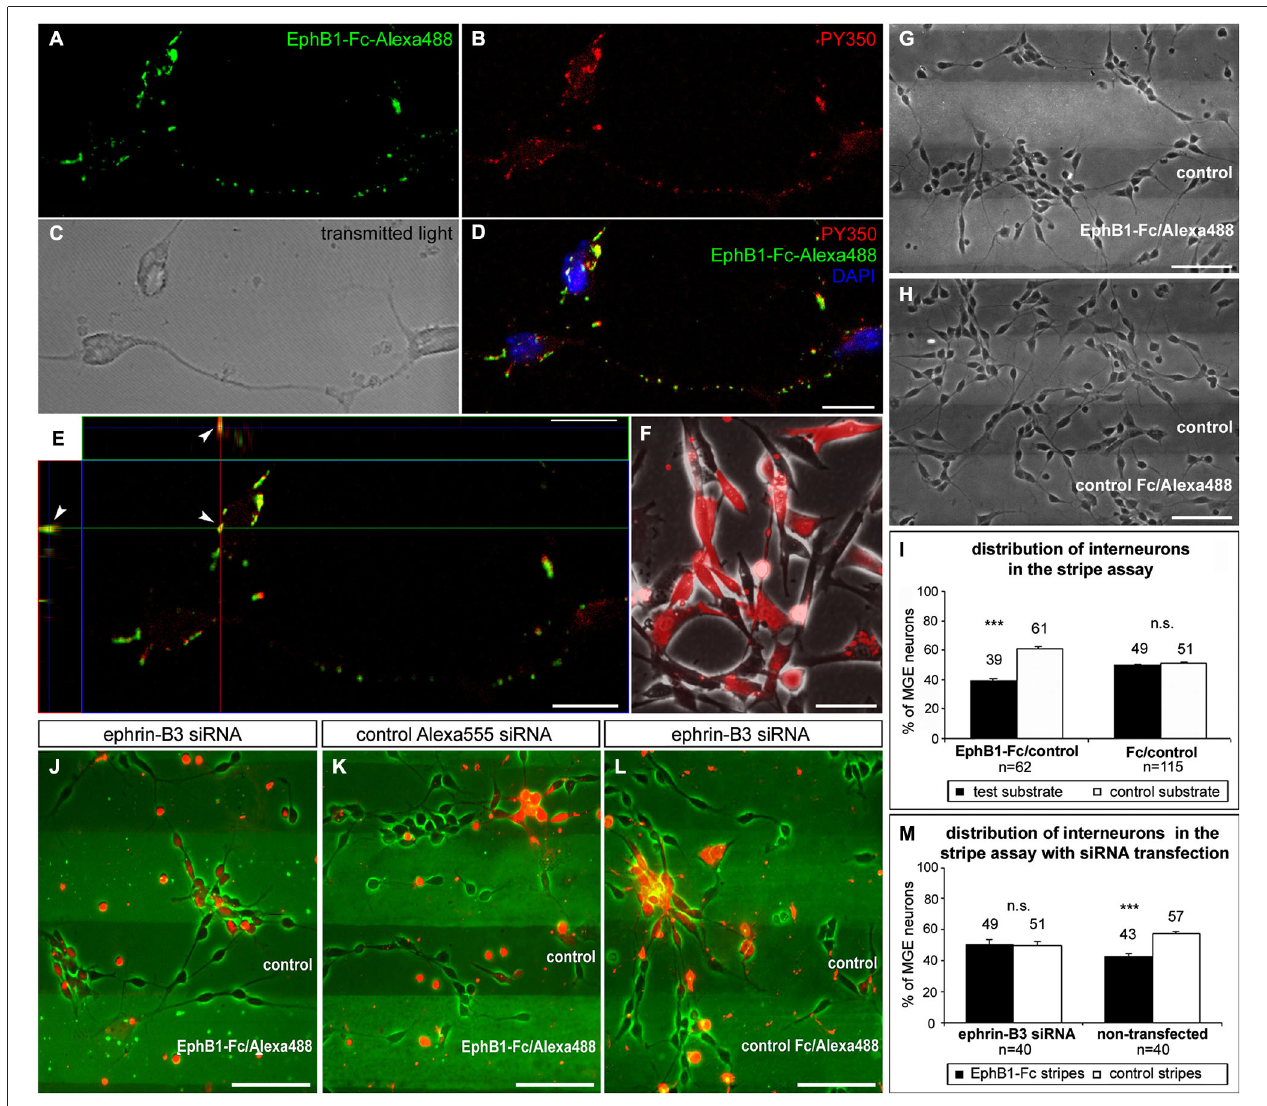
unlabeled control protein the cells show no preferential growth. ( I ) Quantification (mean ± SEM) of the distribution of MGE-derived neurons in the stripe assay with EphB1-Fc and control after 2 DIV. (J) After down regulation of ephrin-B3 ligands by siRNA transfection (red) in MGE-derived neurons the repulsion induced by EphB1-Fc in the stripe assay is abolished after 2 DIV, while non-transfected interneurons still avoid the EphB1-Fc stripes. ( K ) Application of Alexa555 labeled control siRNA has no effect as most of the cells still avoid the EphB1-Fc containing stripes. ( L ) Addition of ephrin-B3 siRNA does not affect MGE-derived neurons growing on Fc/control stripes. ( M ) Quantification (mean ± SEM) of the distribution of neurons in the stripe assay with and without ephrin-B3 siRNA transfection after 2 DIV. Student’s t-test *** p < 0.001. n = number of analyzed images. Scale bars: (D,E) 10 µ m; (F–H), (J–L) 50 µ